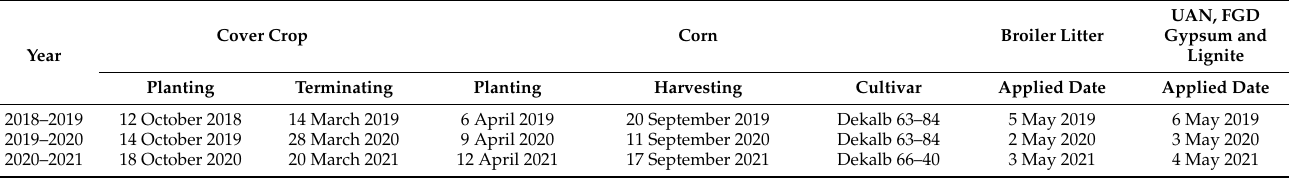
Table 3. Field operations information during three years of